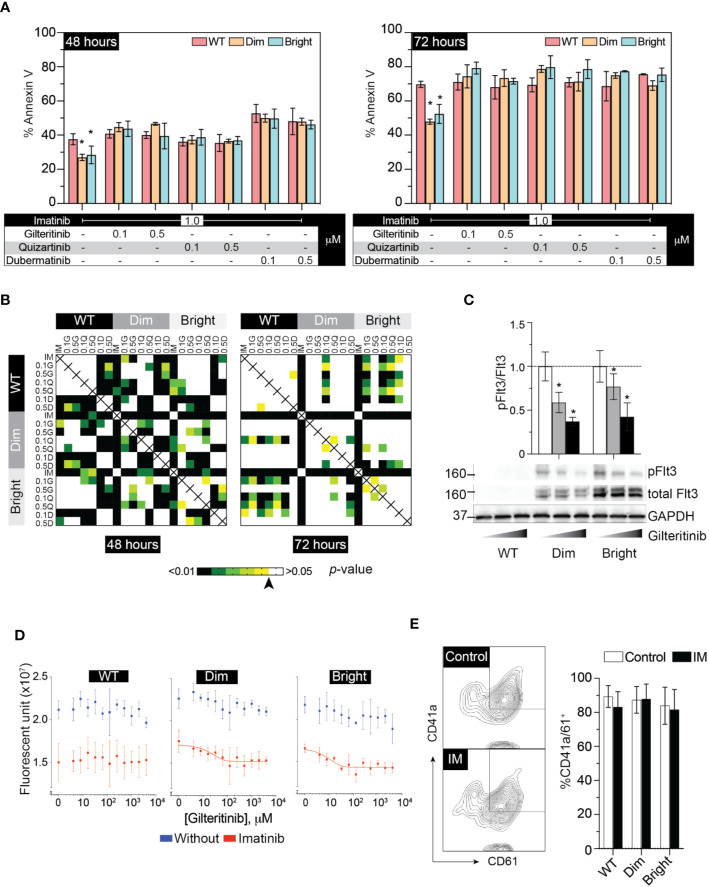
Flt3 mutant protect K562 from IM-induced apoptosis and IM recovers sensitivity to gilteritinib. (A) Flow cytometric analysis of Annexin V and 7AAD following 48–72 h treatment under the indicated condition. Results from three independent experiments are shown as mean ± SD. * indicates significance. (B) Heatmap showing p-value of two-way ANOVA followed by multiple comparison test from apoptosis assay by controlling the False Discovery Rate. Arrow indicates p value = 0.05. (C) Western blot analysis of pFlt3(y842), total Flt, and GAPDH following gilteritinib treatment. (D) Gilteritinib concentration-response curve showing proliferation of wild type, dim, and bright K562 after removing Bcr/Abl1 translocation advantages. Cells were treated with 1 μM imatinib in a low-serum condition for 24 h. Viable cells were analyzed using Cell Titer Blue assay. Results are shown as mean ± SD from three independent experiments in duplicate. When possible, non-linear sigmoidal curve fit using GraphPad Prism are shown. (E) Flow cytometric analysis of CD41a/CD61 after treatment with imatinib. Results from three independent experiments are shown as mean ± SD. IM, imatinib.